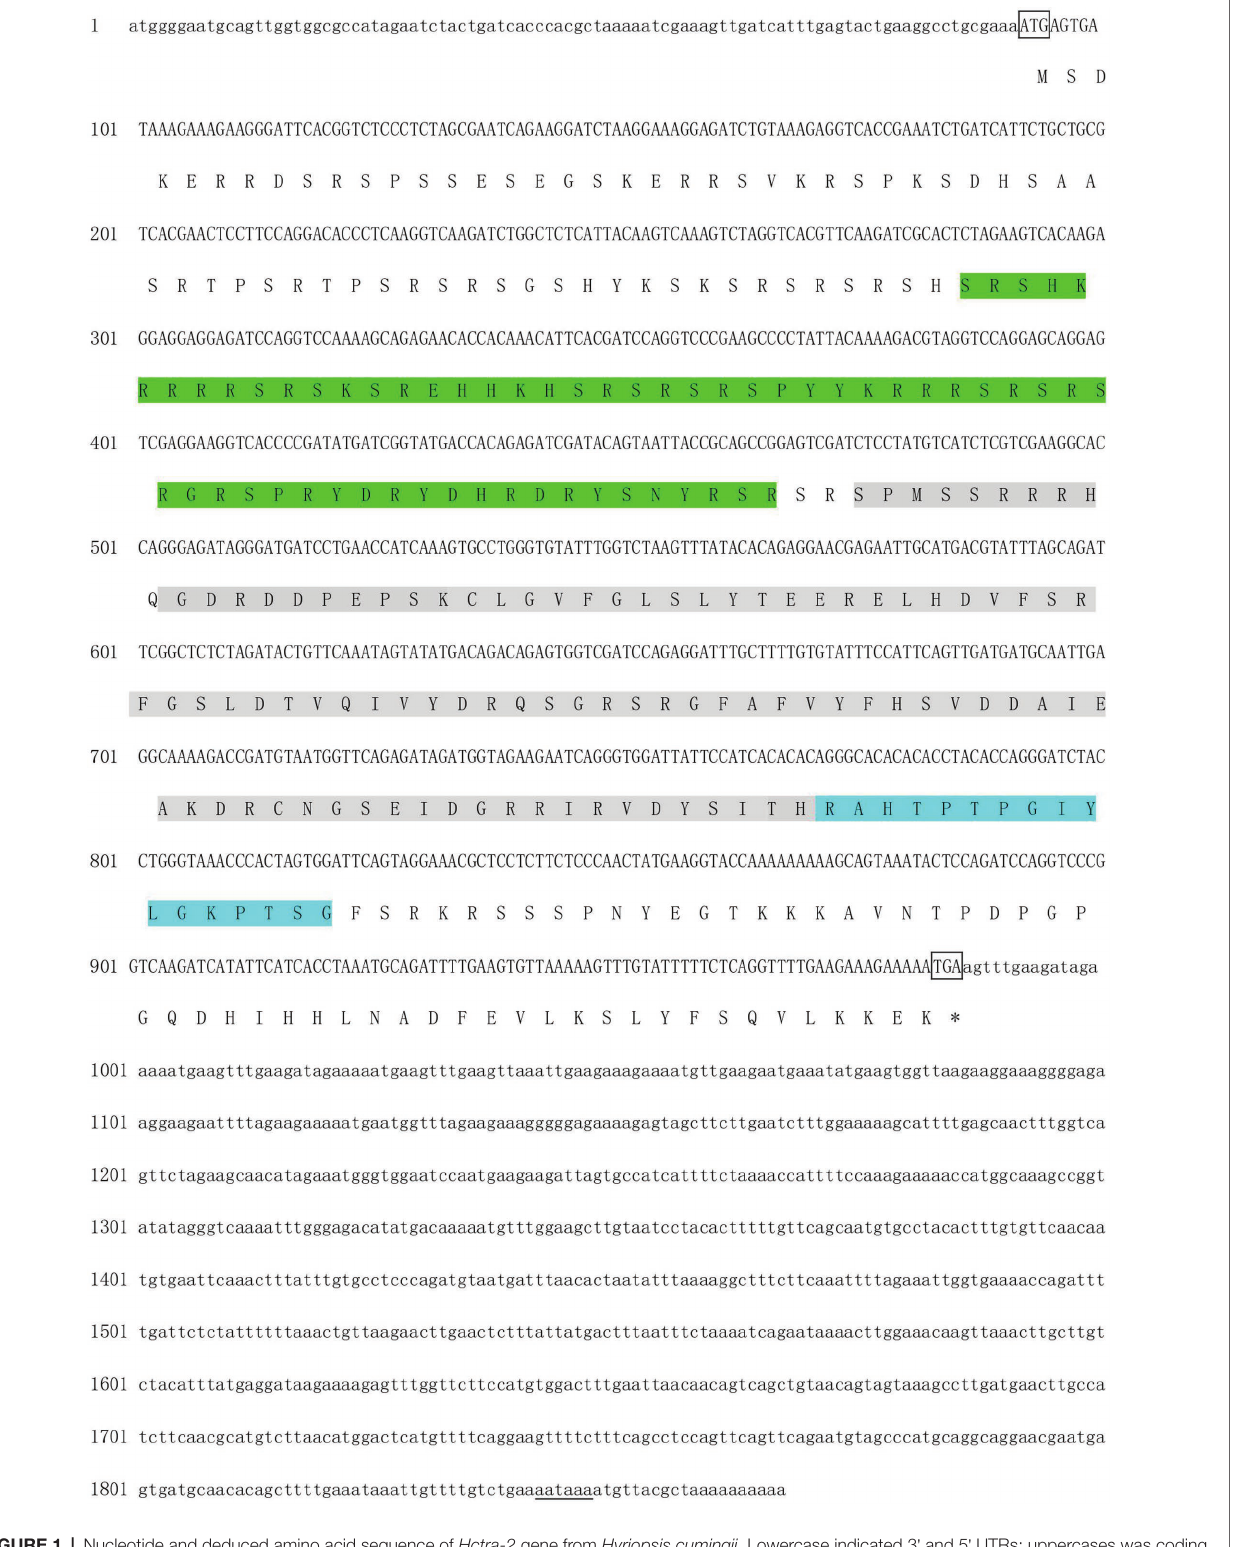
FIGURE 1 | Nucleotide and deduced amino acid sequence of Hctra-2 gene from Hyriopsis cumingii . Lowercase indicated 3 ' and 5 ' UTRs; uppercases was coding region, where the upper indicated the nucleotides sequence and the lower showed the amino acids. * Represented stop codon; putative polyadenylation signals (AATAAA) were underlined. The gray region was the RRM domain. The green region shows the SR1 domain. The blue region shows the